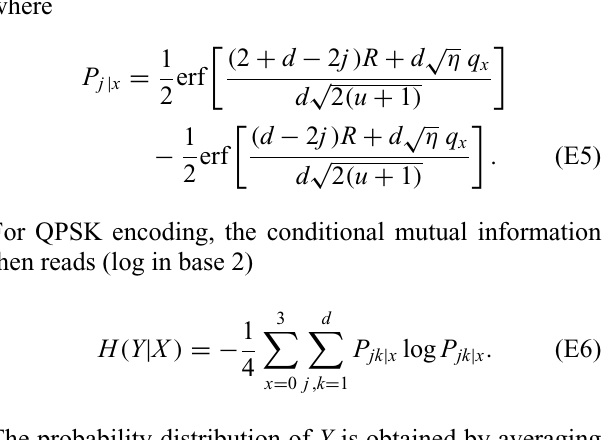
FIG. 3. The optimal values plotted versus the Hilbert space cutoff dim, for Eq. (D7) (circles) and Eq. (D8) (crosses), and for R = 7, d = 16, α = 0.5, η = 0.1, and u = 0.001. The optimal values are largely independent of dim as long as dim ≥ (cid:13) R 2 (cid:14) +